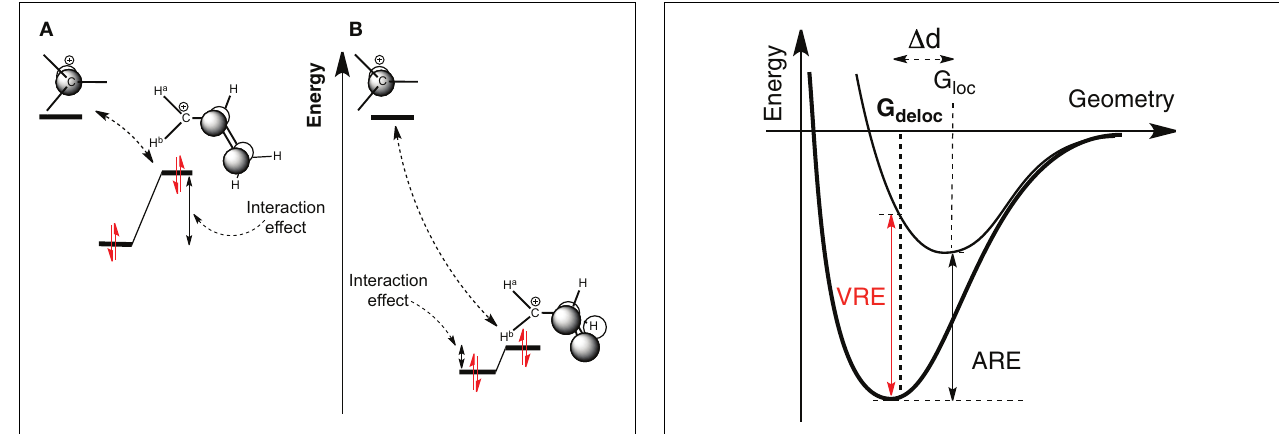
FIGURE 1 | Vertical (VRE) and Adiabatic (ARE) Resonance Energy. In bold is the energy curve of the delocalized wave function, while in plain is the localized. VRE and ARE differ by the geometry used to compute the localized wave function. The optimum geometry with the delocalized wave function is G deloc , and G loc for the localized